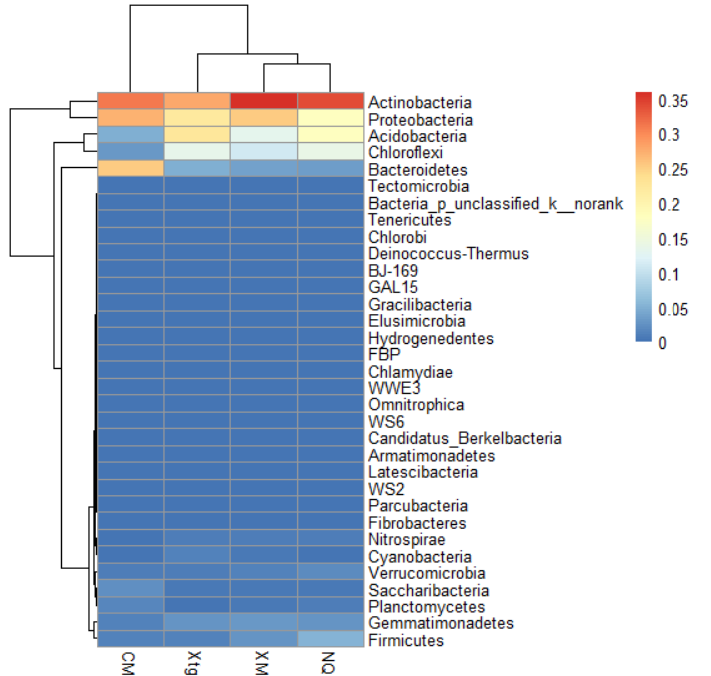
Figure 3. The relative abundance of soil microbes in XM, NQ, Cuoma Township (CM), and Xiaotanggula Mountain (Xtgl). The different colors indicate different relative abundances. The rows specify bacteria and the columns indicate the sampling sites.